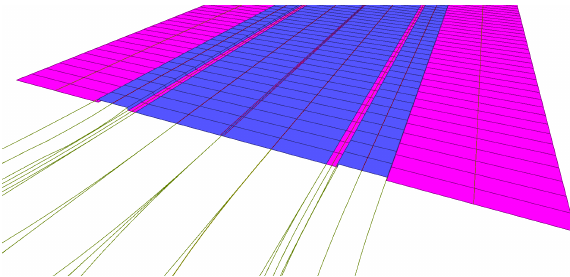
Figure 8. OpenDRIVE sample using road shapes and visualized as CityGML dataset.